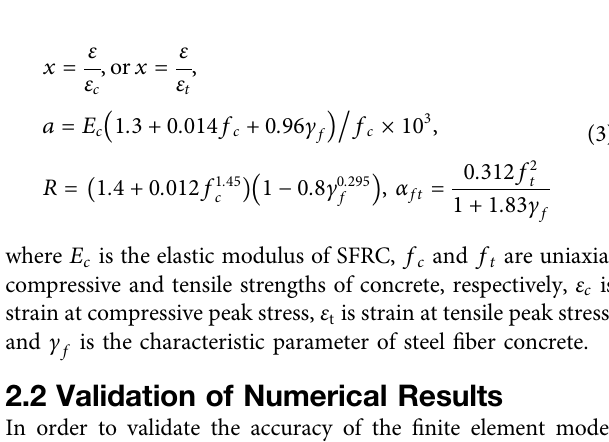
FIGURE 4 | Stress-strain curves of SFRC